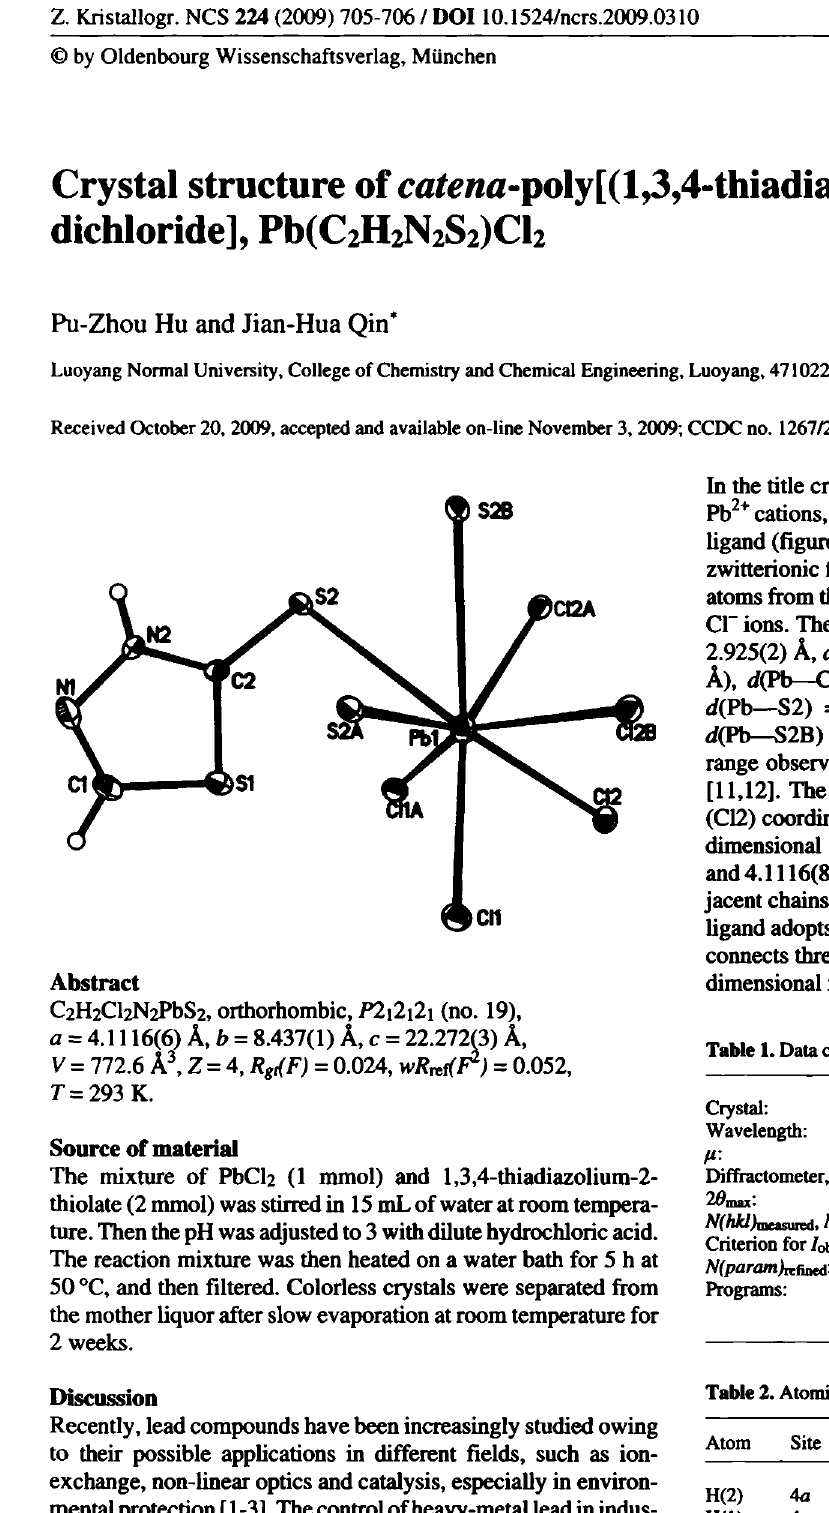
Table 2. Atomic coordinates and displacement parameters (in Ä 2